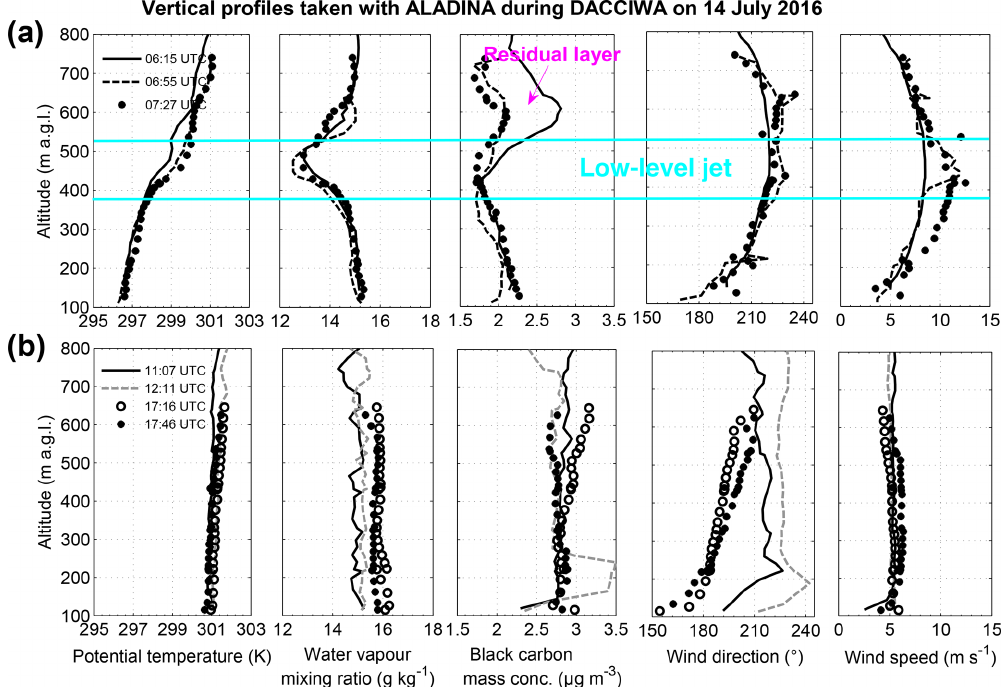
Figure 8. Vertical profiles taken with ALADINA between the height of 100 and 800ma.g.l. on 14 July 2016. From left to right: potential temperature, water vapour mixing ratio, black carbon mass concentration, wind direction, and wind speed (a) in the morning from 06:15 until 07:27UTC and (b) during cloud formation below the height of 800ma.g.l. at 11:07 and 12:11UTC as well as during the evening transition at 17:16 and 17:46UTC. The horizontal turquoise line indicates the altitude range of the nocturnal low-level jet (see Fig. 7a).